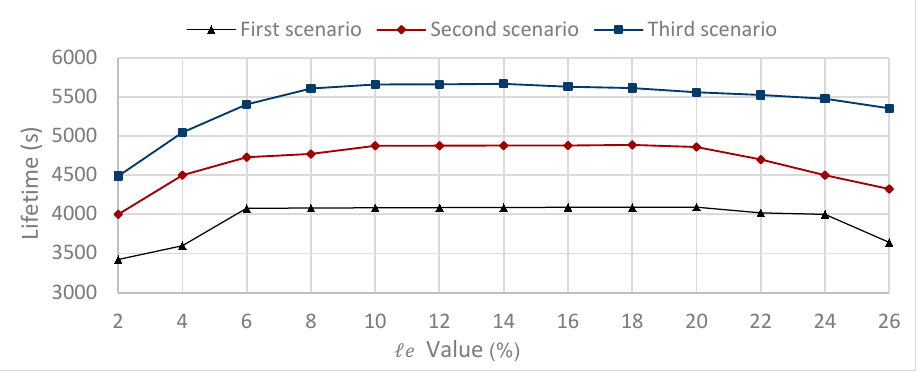
Figure 4. Impact of (cid:96) e parameter on the network lifetime varying number of nodes for the first scenario, the second scenario and the third scenario.